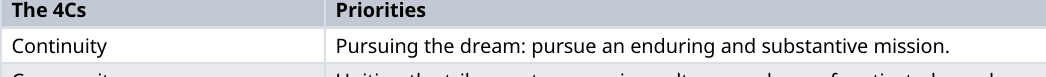
Table 1. The 4Cs of successful family-controlled businesses (based on [Miller & Le Breton-Miller, 2012]). The 4Cs